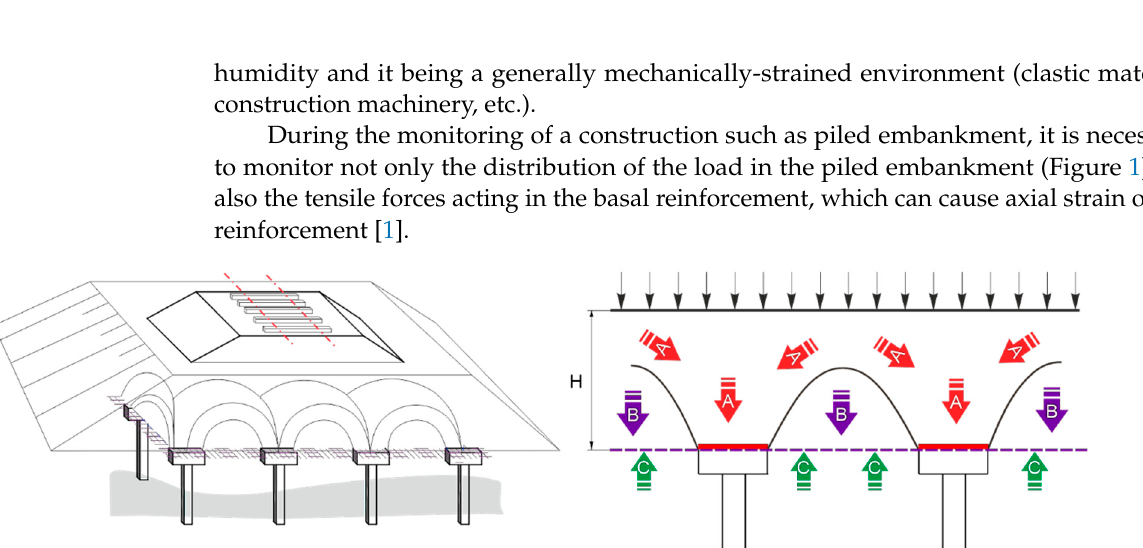
Figure 1. Scheme of piled embankment of railway track ( left ), load distribution on piled embankment in case of full arching ( right ).